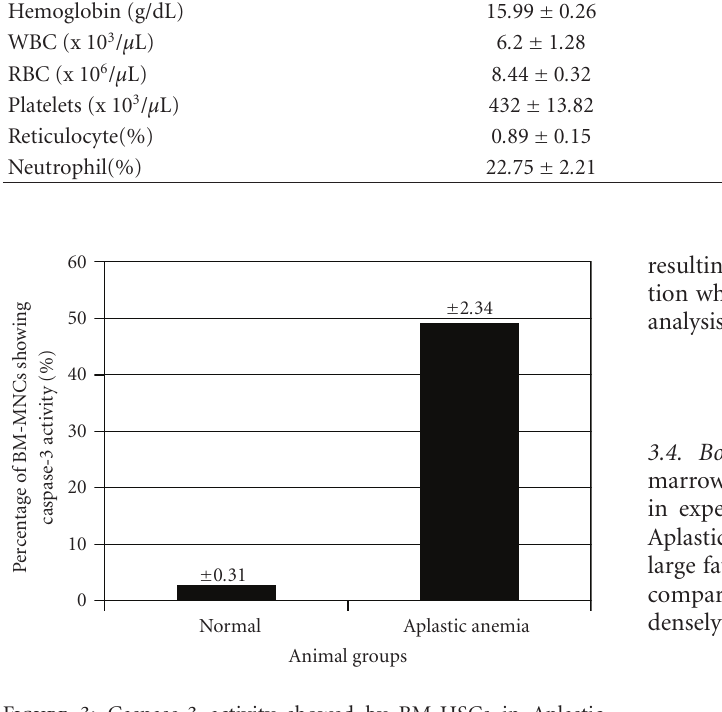
undergo premature apoptosis in Aplastic anemia,